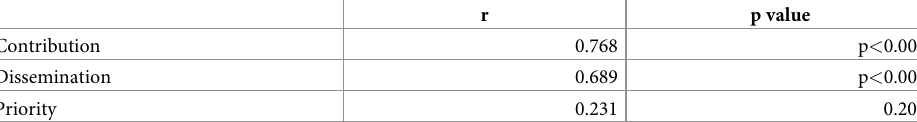
Table 3. Correlations between perspective scores assessed by experts and safety